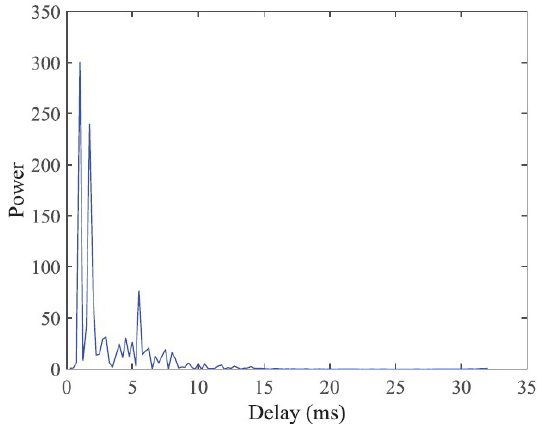
Figure 12. Estimated power of the CIR during the tank experiment.